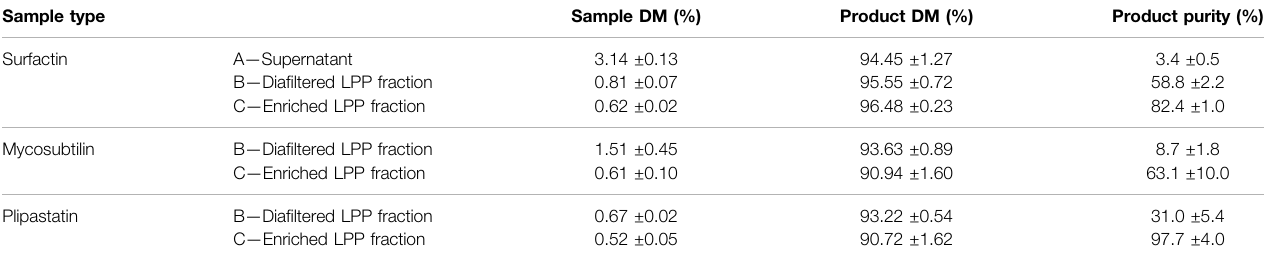
TABLE 3 | Dry matter values measured for each spray-dried lipopeptide sample on the liquid solution before drying (Sample) and on the dried powder obtained (Product). Sample type